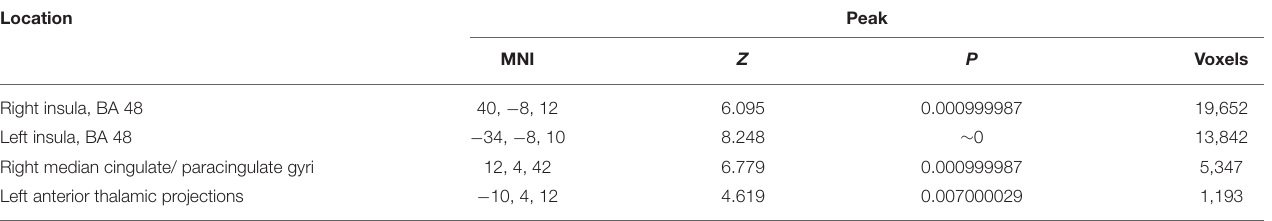
TABLE 4 | Brain regions engaged during oddball detection